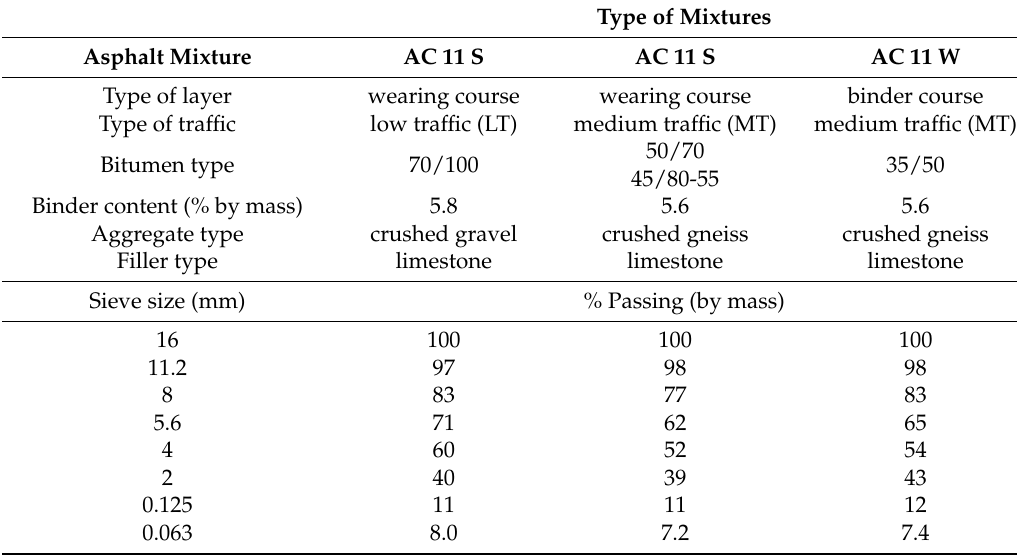
Table 2. Properties of asphalt mixtures.